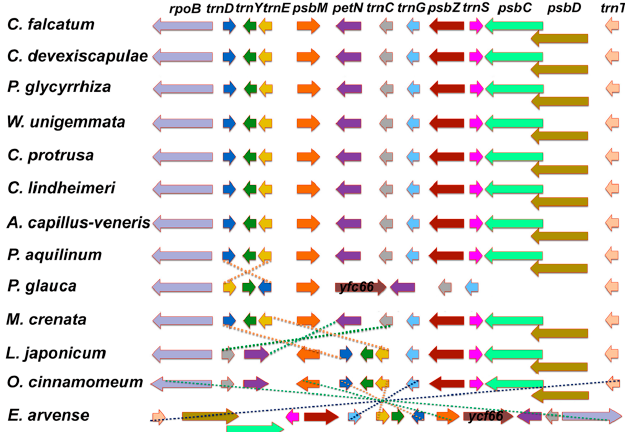
Figure 3. Gene organization from rpoB to trnT among analyzed ferns. The arrows correlate with the location, size and transcription direction of the corresponding genes. Dashed lines indicate putative local inversions within the corresponding cp genomes. Fern species are derived as follows: C . falcatum: Cyrtomium falcatum ; C . devexiscapulae: Cyrtomium devexiscapulae ; P . glycyrrhiza: Polypodium glycyrrhiza